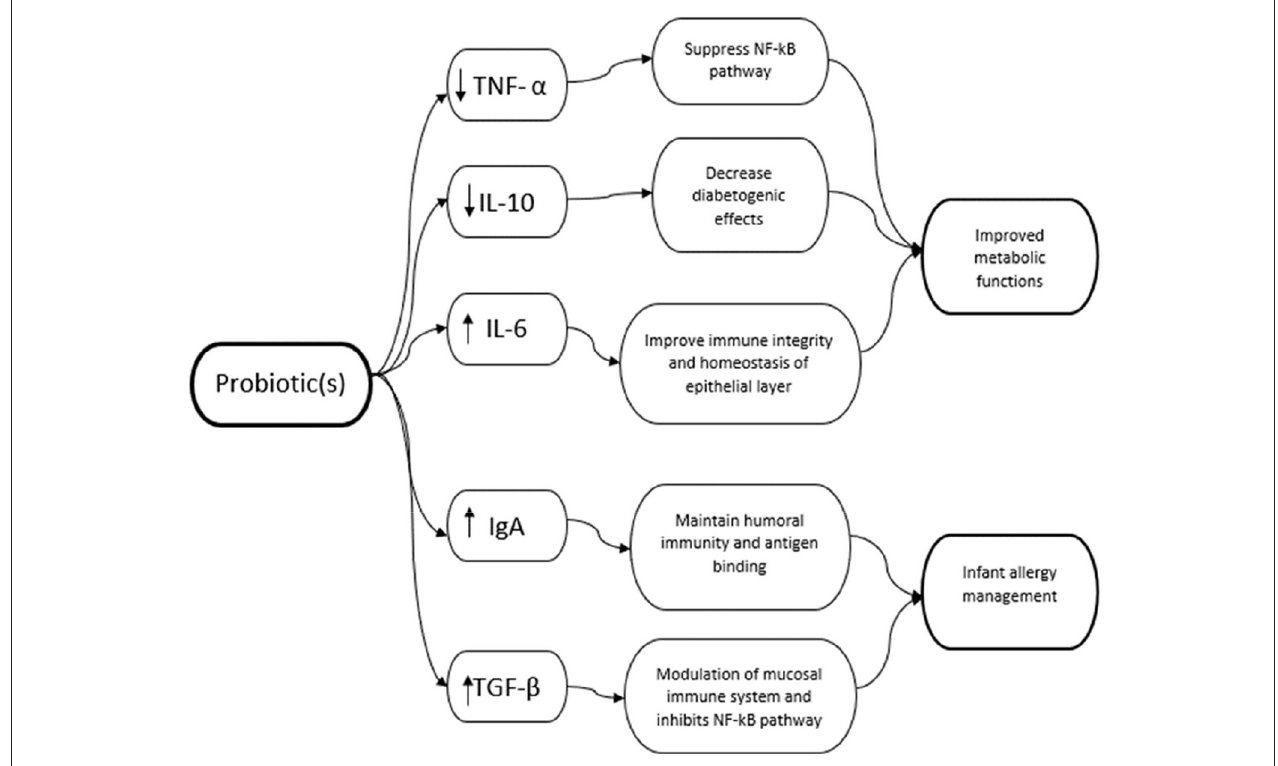
FIGURE 2 | Relevant inflammation markers and health